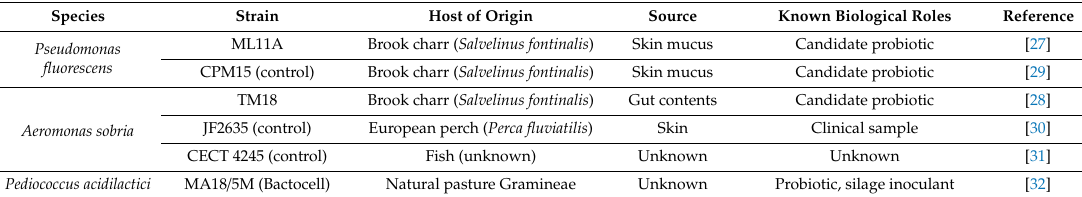
Table 1. Bacterial strains used in this